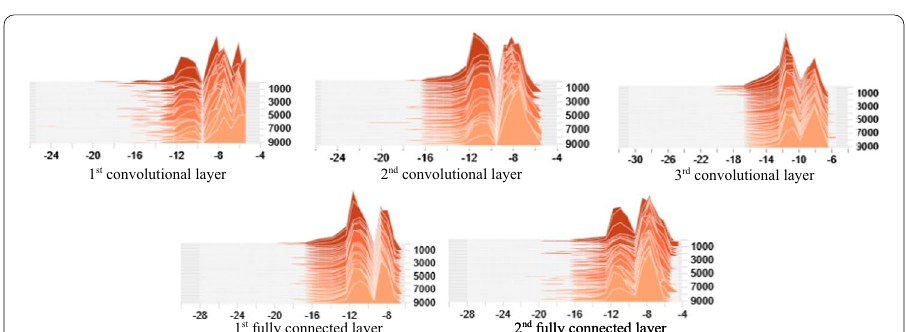
Fig. 7 Weights gradient exponent values utilization during training of the network (per training batch)